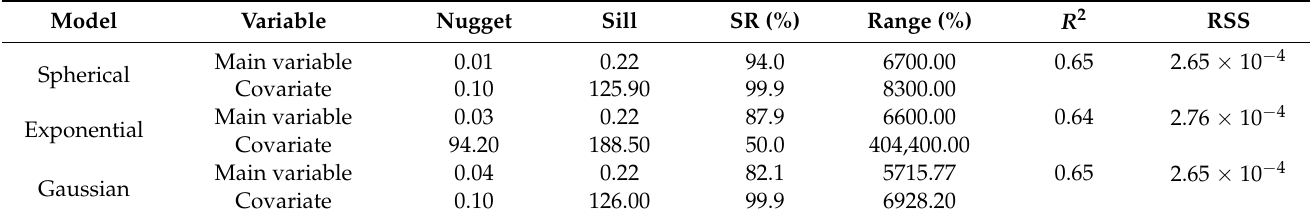
Table 6. The related parameters and evaluation index of cokriging variation